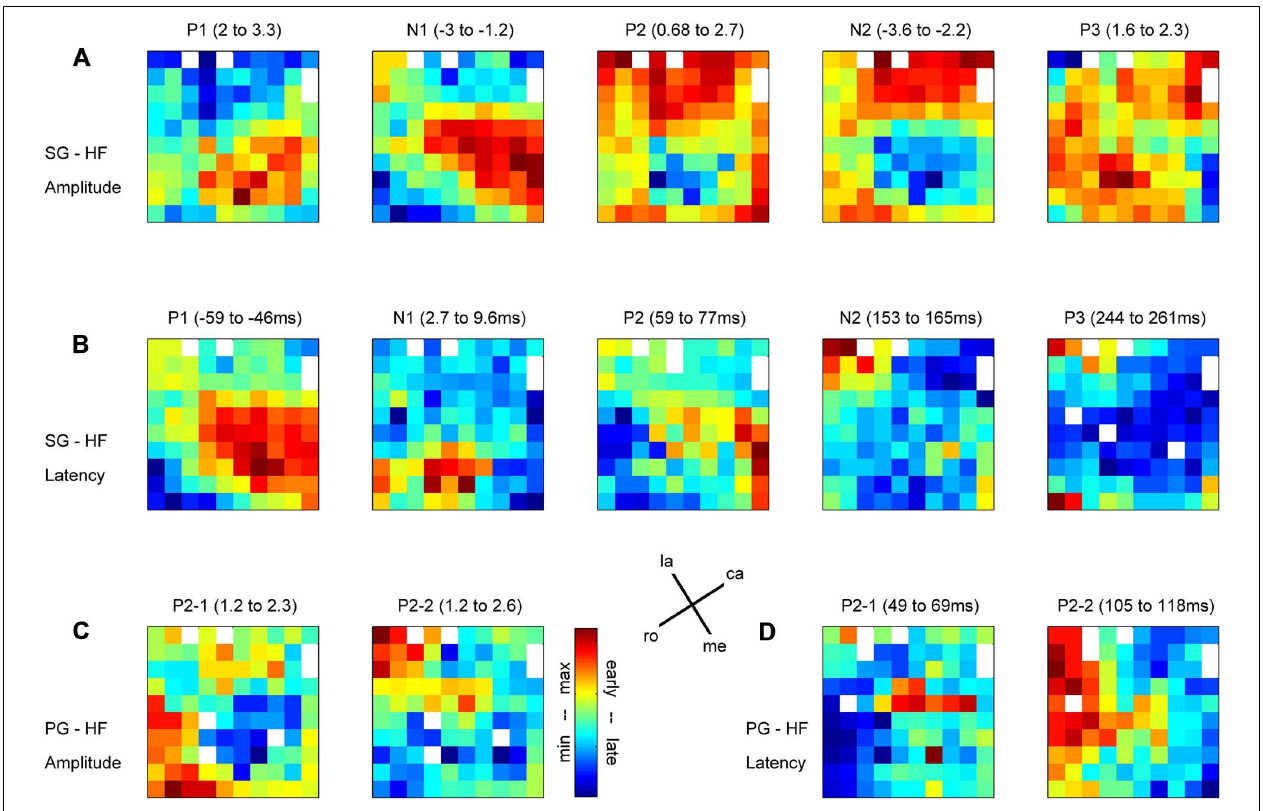
FIGURE 4 | Maps of peak amplitudes (A,C) and latencies (B,D) of the different components of the MRP averaged across all selected subsessions; n = 18 in (A,B); n = 12 in (C,D). Color code is in absolute values and adapted to each component separately. Above each map, the MRP component and the min–max values are indicated in z -score for the